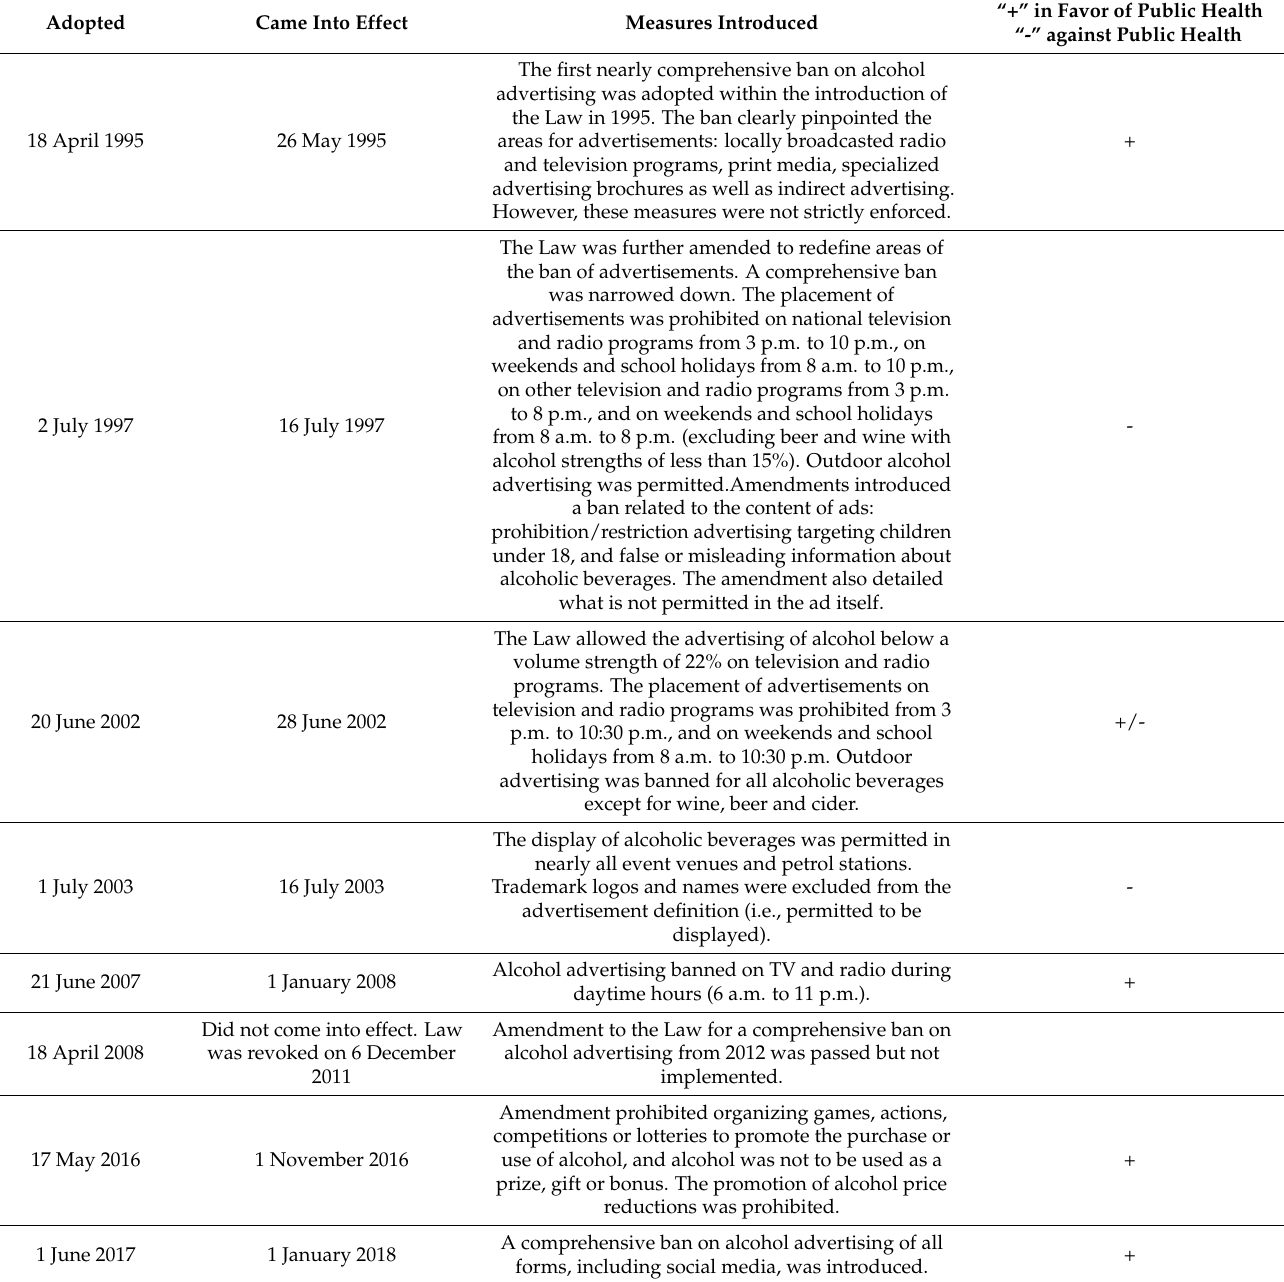
Table 1. Developments of the regulation of alcohol advertising in